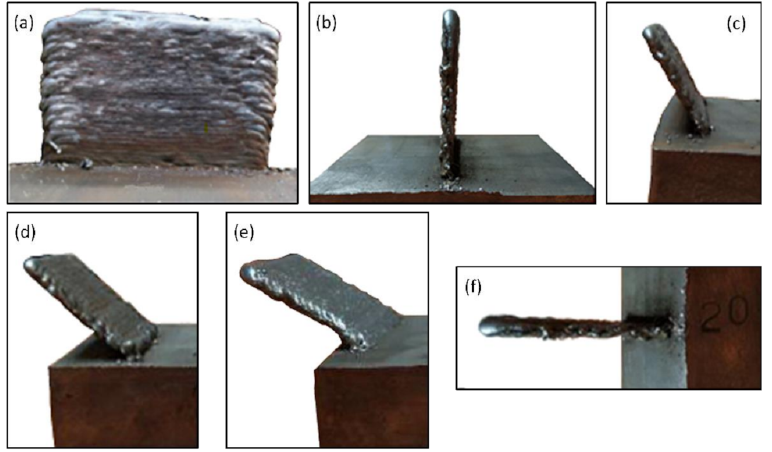
Figure 12. ( a ) Sample E5 α n = 90 ◦ , front view; ( b ) Sample E5 α n = 90 ◦ lateral view; ( c ) Sample F1 α n = 60 ◦ ; ( d ) Sample F2, α n = 45 ◦ ; ( e ) Sample F3, α n = 30 ◦ ; ( f ) Sample F4 α n = 0 ◦